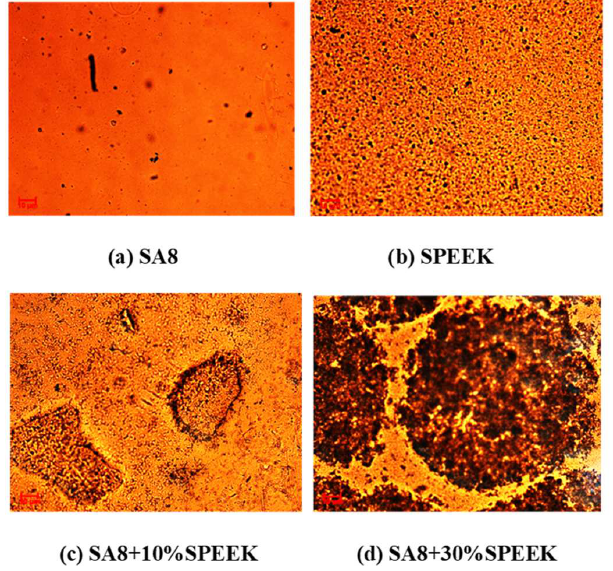
Figure 22. The morphology diagram of SA8 blended with sPEEK.